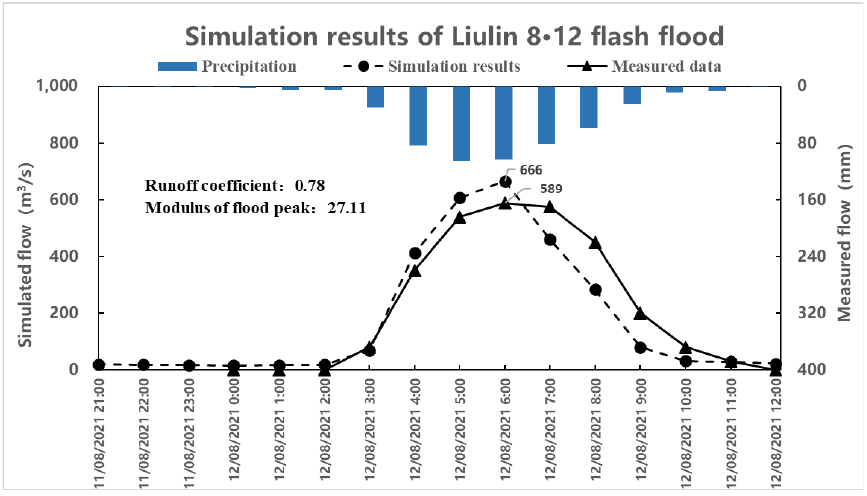
Figure 7. Simulation results.